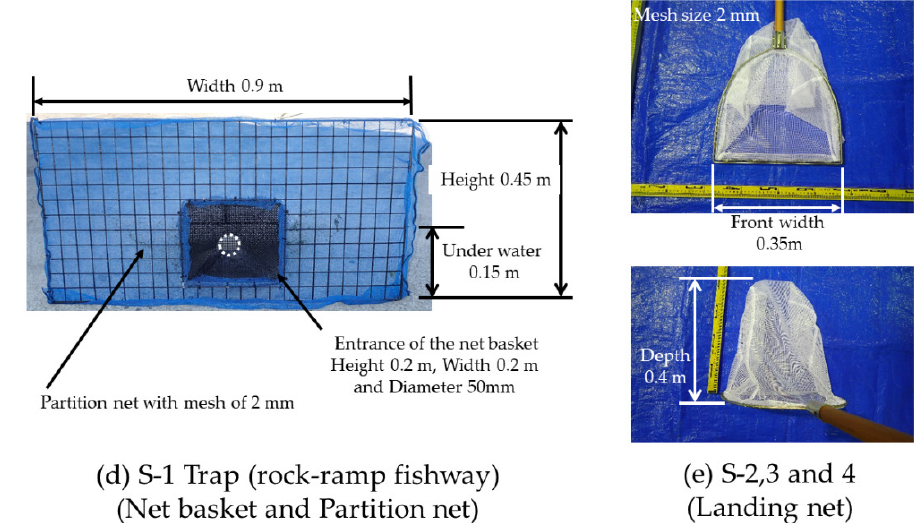
Figure 3. Fishway monitoring status. ( a ) The traps were installed at the upstream ends (S-1) of the ice-harbor, stair-type and rock-ramp fishways. The survey points in the rock-ramp fishway were set at not only the upstream end but also the midpoints. ( b ) The number and widths of the traps were adjusted according to the fishway’s width to prevent gaps between the traps. One trap was installed on the rock-ramp fishway, and no traps were installed at the midpoints of the rock-ramp fishway. ( c ) The traps installed in the ice-harbor and stair-type fishways consisted of iron frames fixed to the fishway during the survey and net baskets. (c-1) On the downstream side of the net basket, the guide part was installed. (c-2) At the connection between the net basket and guide part, the entrance to the fish was prepared. ( d ) The trap installed at the upstream end survey point of the rock-ramp fishway comprised a small net basket commonly used to catch sculpins. ( e ) Landing nets were used in the survey of the midpoints (S-2, 3, and 4) of the rock-ramp fishway. Table 2. Survey methods upstream and downstream from the dam. The fishing gear, specifications, and amount of effort were based on the River Waterside Census conducted by the MLIT nationwide. To catch various fish, the surveys were conducted according to the habitat of the survey